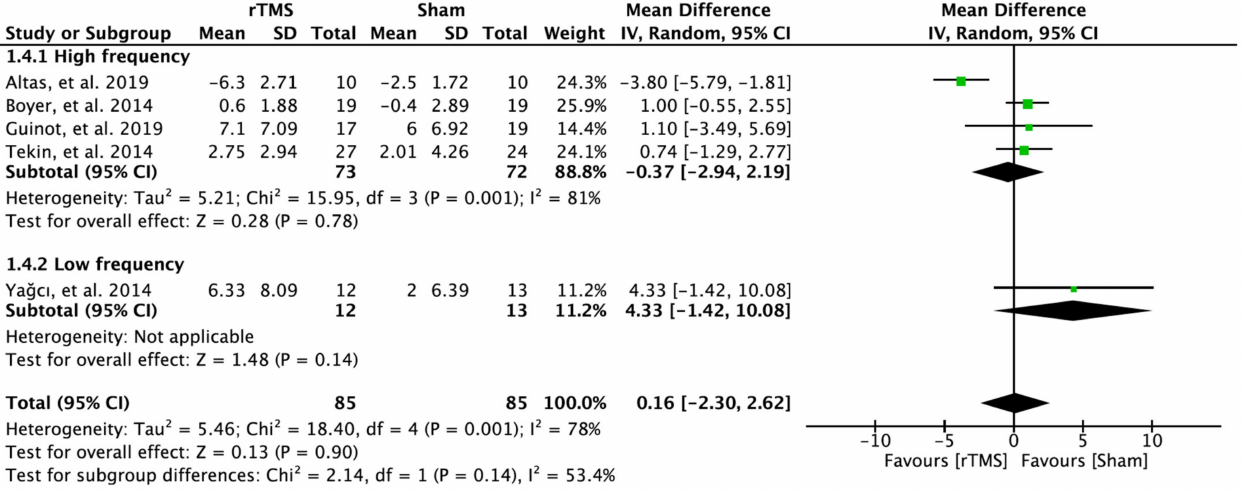
Figure 6. Forest plot on the effect of repetitive transcranial magnetic stimulation on